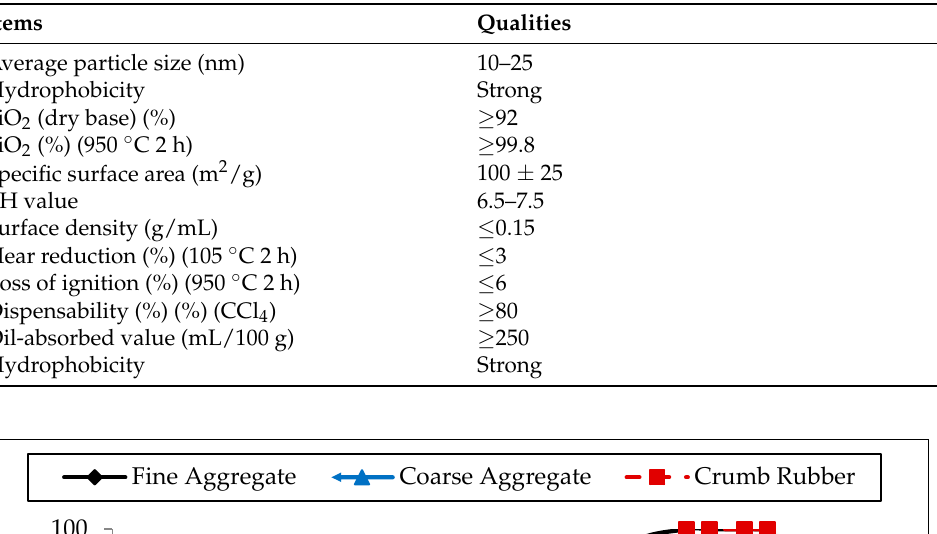
Table 2. Characteristics of binder.